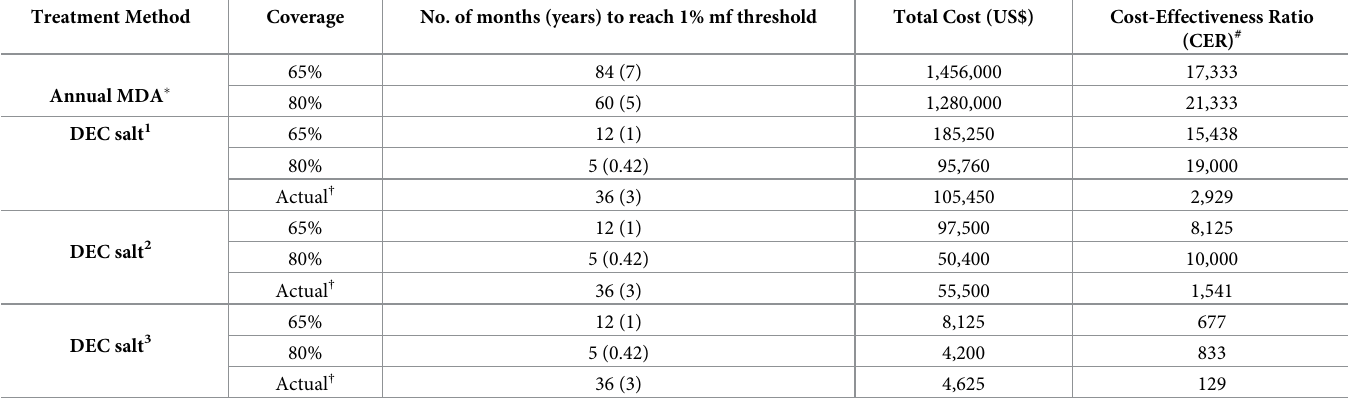
Table 6. Comparison of total costs and CE ratios of population treatment using MDA versus supply of DEC-medicated salt for different drug coverages and DEC salt costs. Treatment